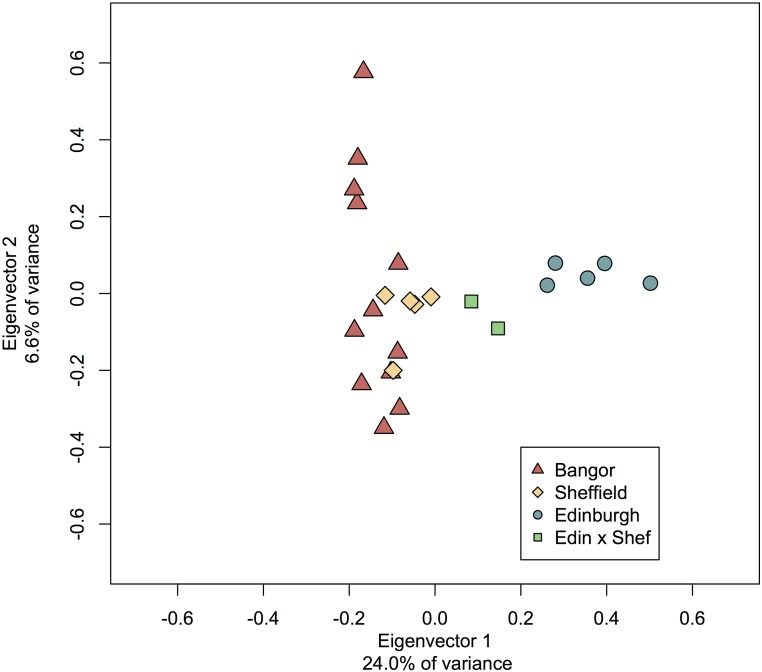
PCA of 28,885 autosomal SNPs. Eigenvector 1 explains the majority of the diversity in these samples and strongly differentiates the Edinburgh colony from the others. Sheffield contains a subset of the genetic diversity found within Bangor colony. F1 offspring between Edinburgh female and Sheffield male are intermediate.